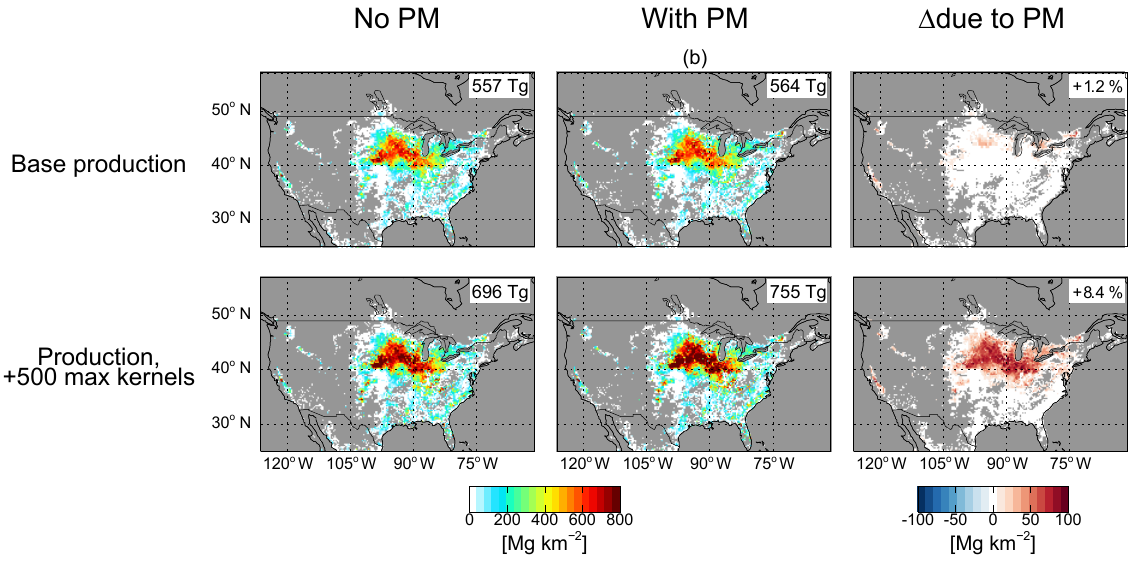
Figure 5. For pDSSAT base production (top row panels) and production with increased maximum kernels per plant (bottom row panels) under no stress: maize production with no PM (left column panels), maize production with PM (with max (cid:49) RUE = 100%) (middle column panels), and maize production due to PM (right column panels). Filtered for GAEZ base crop production greater than 0.01Mgkm − 2 . Global production (left and middle column panels) or relative production change (right column panels) shown in upper right of each map.